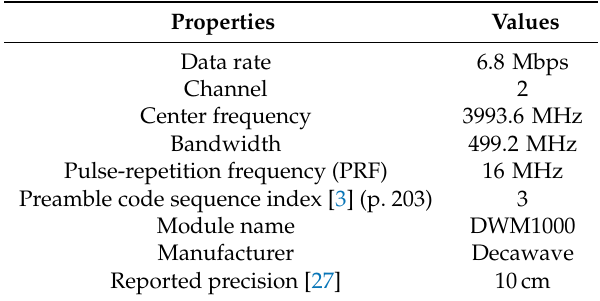
Table 3. Used Ultrawide Bandwidth (UWB) configuration in the